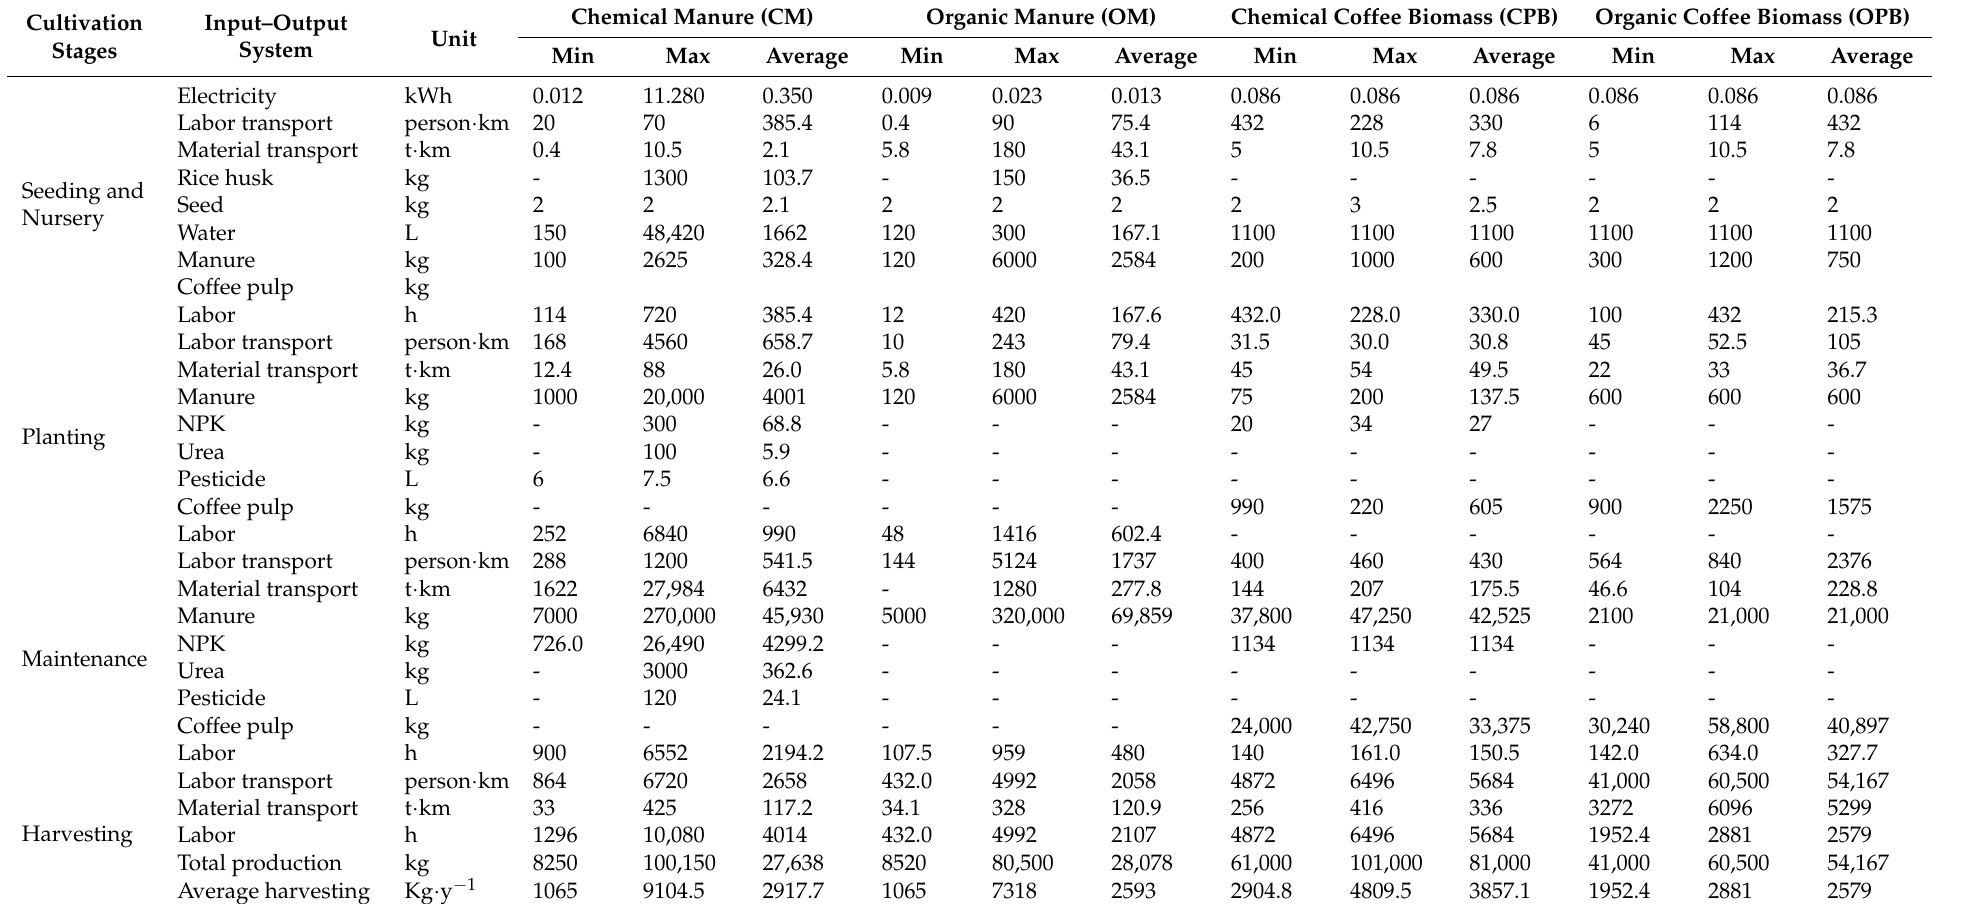
Table A2. Inventory analysis of managing a 1 − hectare coffee